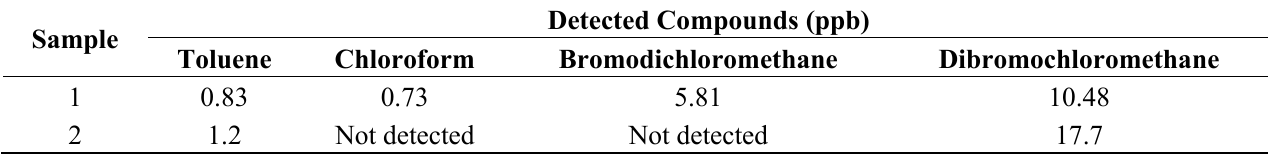
Table 3. Micro-pollutants concentrations in circulated drinking water samples in the coated tank.